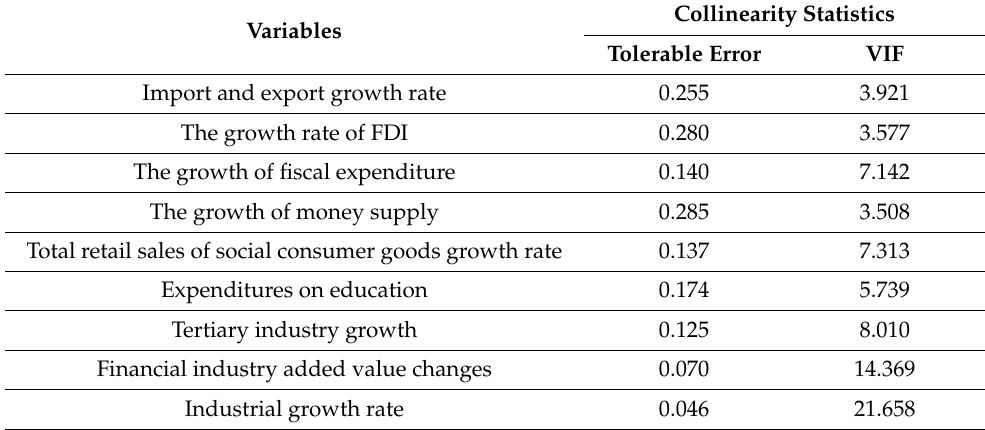
Table 4. Collinearity